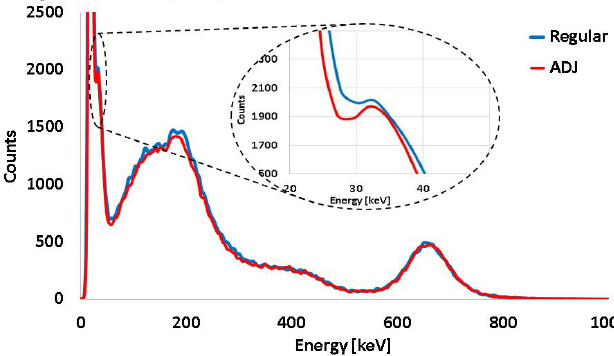
Fig. 11. Spectrum of 137 Cs obtained without the use of the breakdown correction topology, "Regular", in blue, and with the topology, "ADJ", in